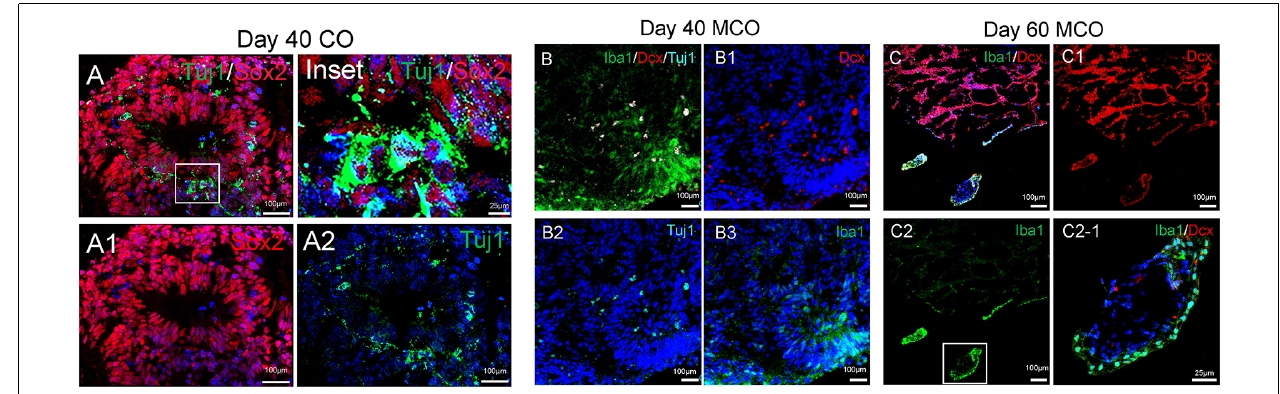
FIGURE 3 | Identification of neural stem/progenitor cells (Sox2), neuroblast (Dcx), immature neurons (Tuj1), and microglia-like cells (Iba1) in developing CO and MCOs detected by multilabeled immunofluorescent confocal imaging with indicated cellular markers. (A) CO at day 40. (B) MCOs at day 40 and (C) at day 60. Hoechst was used as a nuclear marker. Panels (A1–A2) , (B1–B3) , and (C1–C2) are the split channels for (A) , (B) , and (C) , respectively. Panel (C2-1) is digital zoom-in of the inset in (C2) .